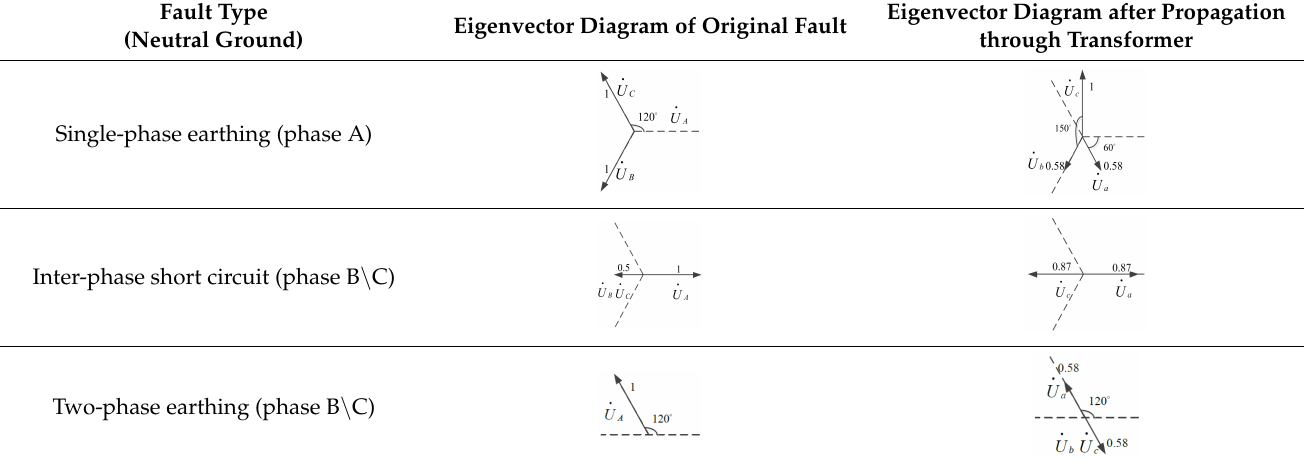
Table 3. Voltage eigenvector change after fault